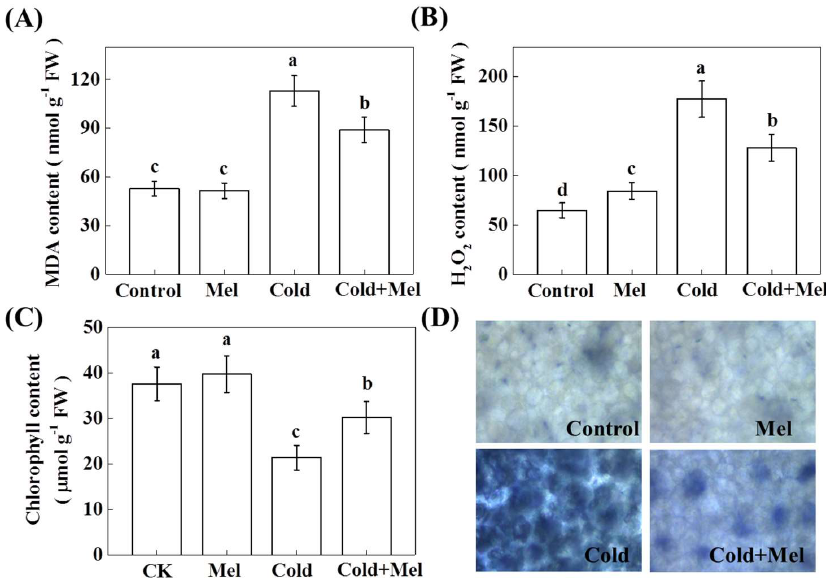
Figure 3. Effect of melatonin application on different stress-related parameters. ( A ) malondialdehyde (MDA) content; ( B ) hydrogen peroxide (H 2 O 2 ) content; ( C ) chlorophyll content and ( D ) in situ O 2 •− accumulation by NBT staining. Mel, melatonin. Each data point presents the mean of six replicates ( ± S.D. (standard deviation)). Means denoted by different letters are significantly different ( p < 0.05) based on the Tukey’s